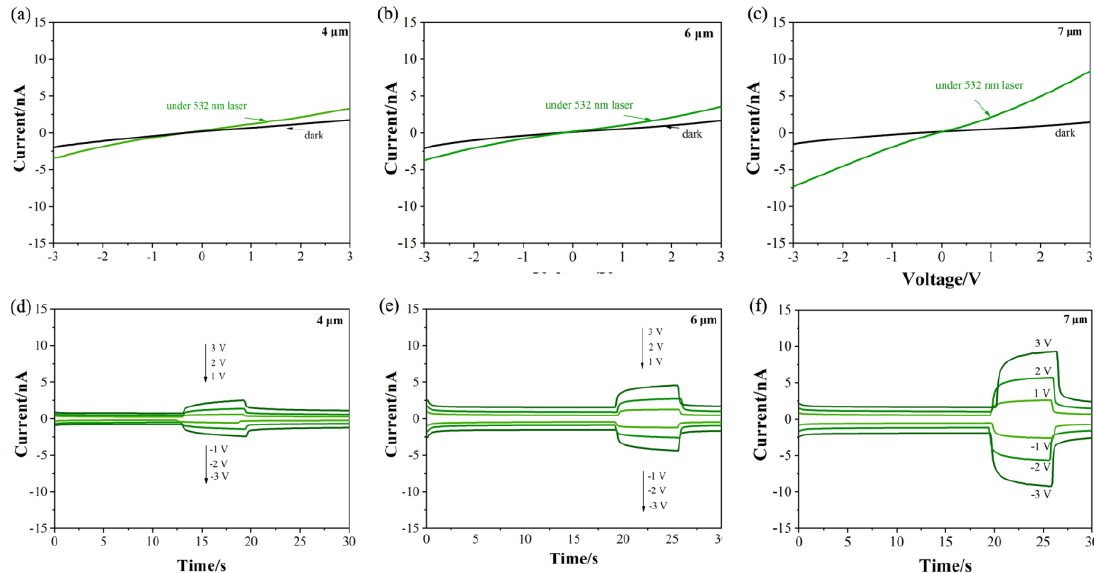
Figure 5. Performance of TNA-based PDs with different tube lengths in the dark and under a 532 nm laser: ( a ) 4 μm; ( b ) 6 μm; ( c ) 7 μm. Fast response measurements with different tube lengths: ( d ) 4 μm; ( e ) 6 μm; ( f ) 7 μm. (laser power: 5.3 mW).